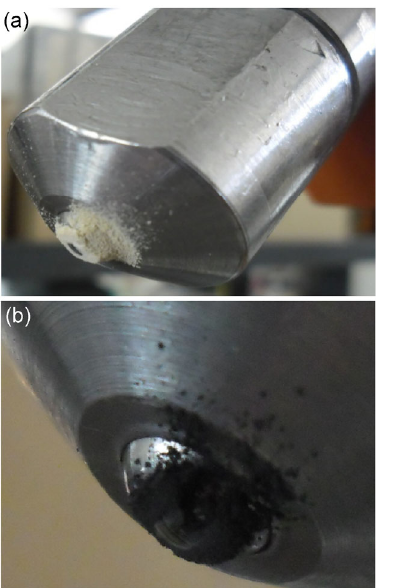
Fig. 10 Schematic diagram showing the effect of carbon additives on the wear resistance of epoxy matrix: (a) stage 1, (b) stage 2, (c) stage 3, and (d) stage